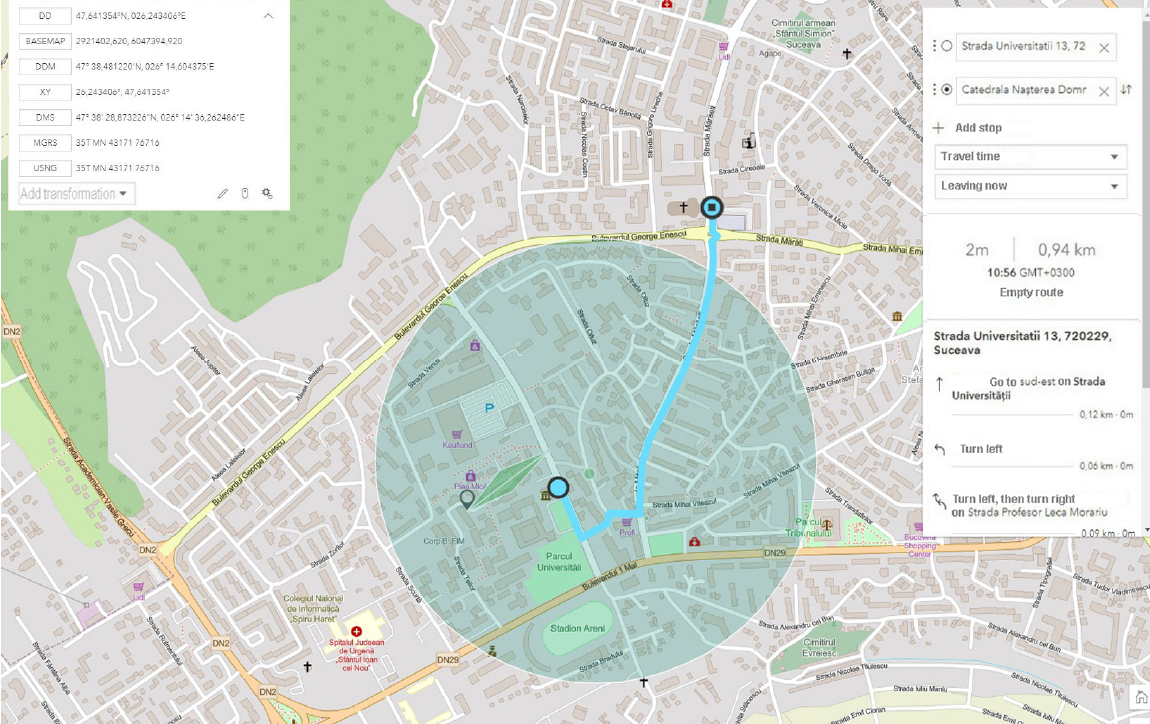
Figure 22. Complete scenario and simulated